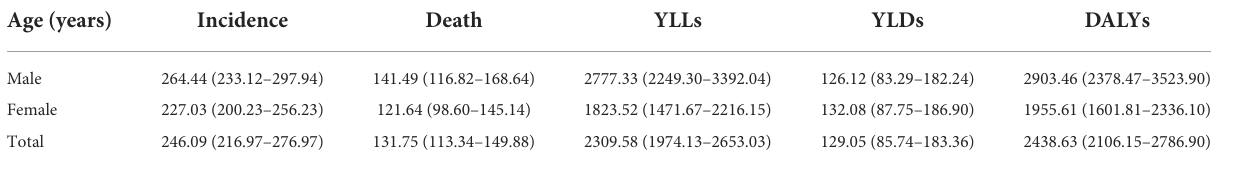
TABLE 2 Gender differences in disease burden of IHD in China in 2019